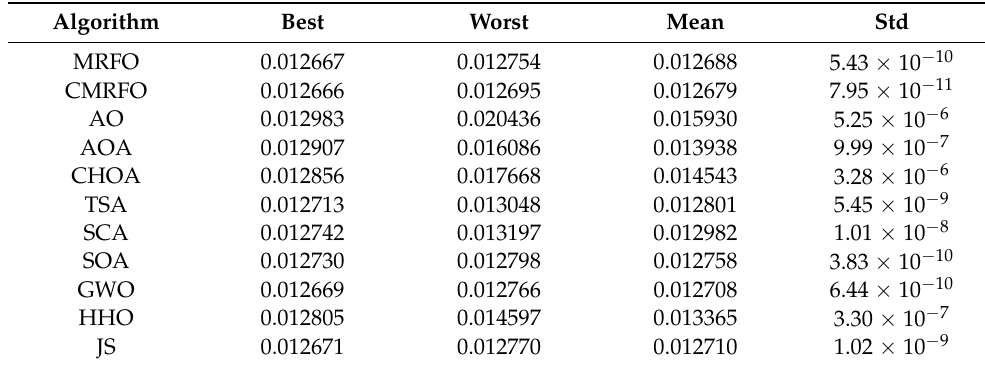
Table 13. Comparison results of all 11 algorithms after 30